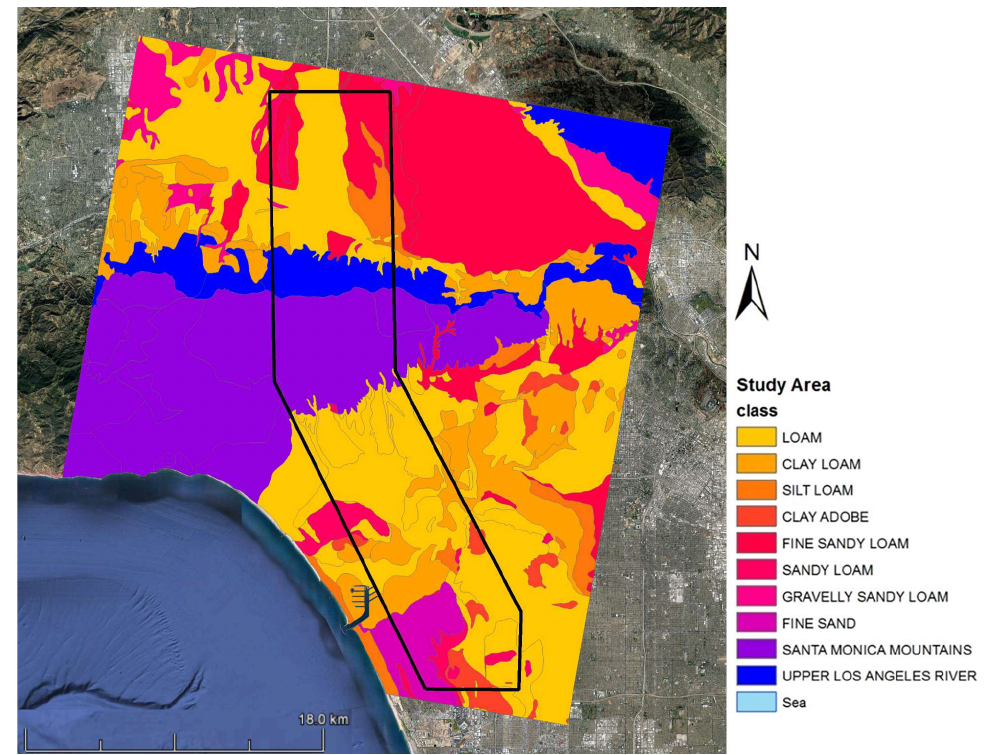
Figure 10. Surface soil map of the study area. The map is created based on raw soil data provided by the Los Angeles County Department of Public Works, Water Resources Division.